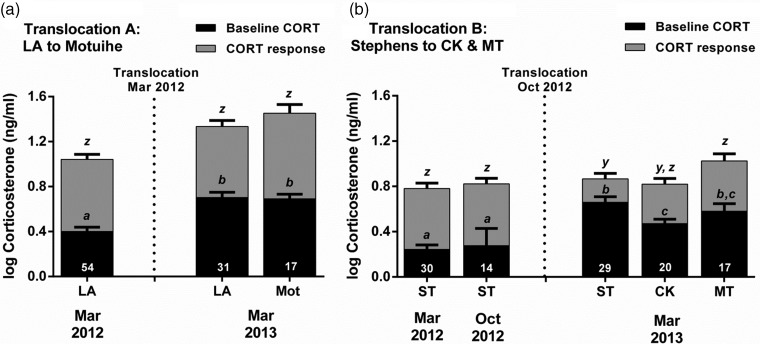
Long-term monitoring. Dynamics of corticosterone (CORT) secretion (shown as means + SEM) in populations of tuatara (S. punctatus) translocated to: (a) Motuihe Island from Lady Alice Island (LA); and (b) Cape Kidnappers Sanctuary (CK) and Sanctuary Mountain Maungatautari (MT) from Stephens Island (ST). Sample size (n) is indicated by the number at the base of each bar and represents a paired sampled of baseline CORT (black bars) and the CORT response (3 h minus 0 h; grey bars) taken from all individuals. Bars that share identical letters are not significantly different (P > 0.05).